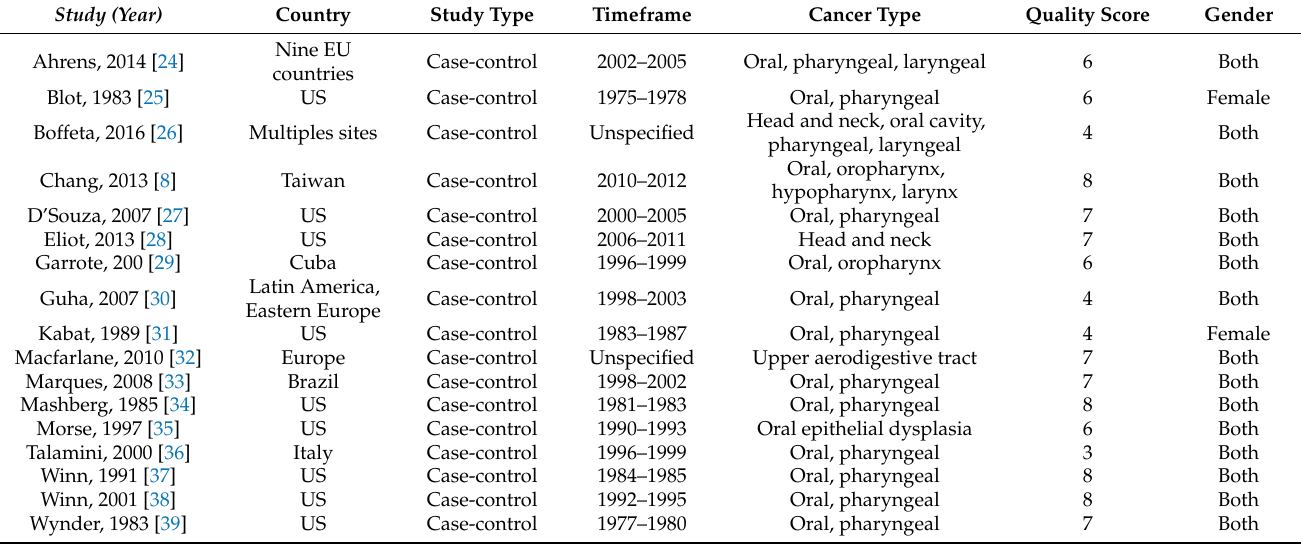
Figure 1. PRISMA flow diagram [23]. Table 1. Studies included in the